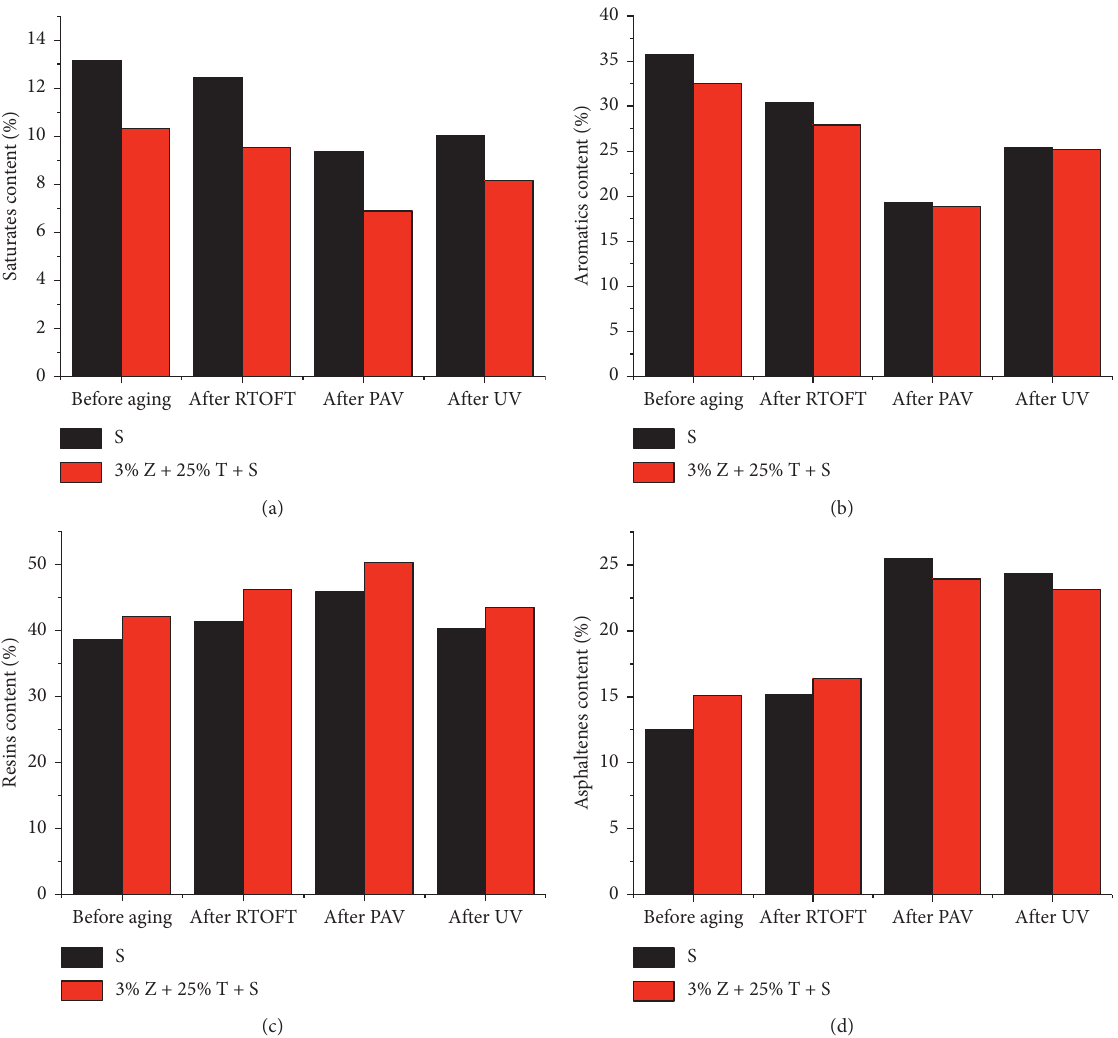
Figure 8: Effect of nano-ZnO (Z) and TLA (T) on the composition of SBS asphalt (S) after aging. (a) Saturates content for asphalt. (b) Aromatics content for asphalt. (c) Resins content for asphalt. (d) Asphaltenes content for